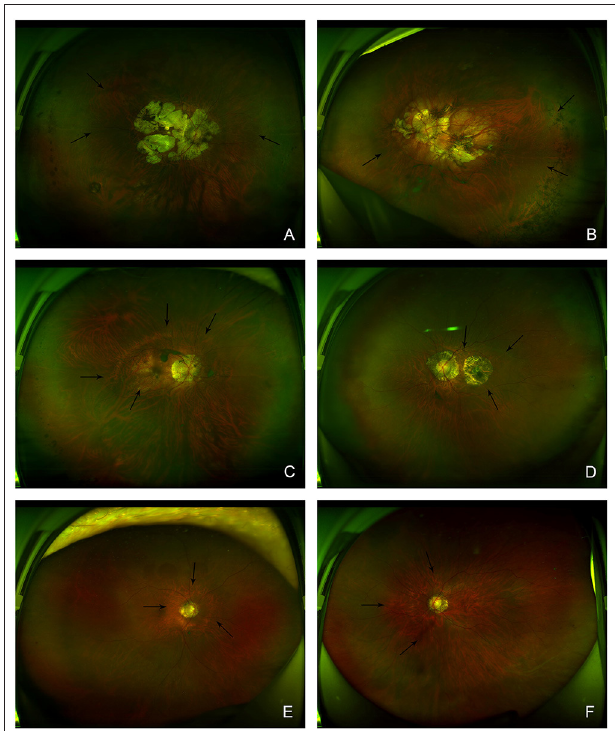
FIGURE 1 | Representative wide-field fundus images of posterior staphyloma. (A,B) Eyes with a wide macular staphyloma. Posterior fundus shows fibrovascular tissue and focal chorioretinal atrophy. Focal chorioretinal atrophy has spread widely and the posterior fundus shows a bare sclera appearance. (C,D) Eyes with a narrow macular staphyloma. Posterior fundus shows a relatively narrower focal chorioretinal atrophy. (E,F) Eyes with other types of staphylomas. In a typical peripapillary staphyloma, focal chorioretinal atrophy is closer-set and tends to be restricted to the optic disc. Arrows shows the edge of posterior